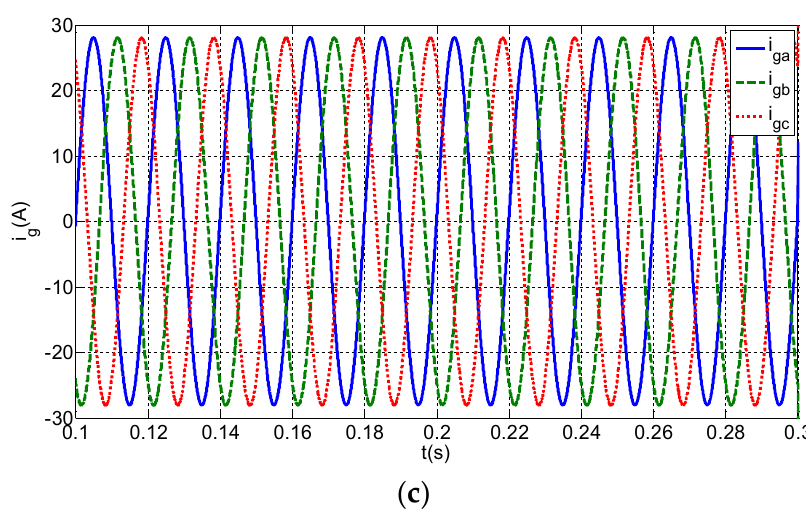
Figure 22. Steady state simulation waveform of unbalanced load compensation: ( a ) Three-phase unbalanced load current; ( b ) The output current of the SPC device; ( c ) Grid current after compensation. A GDS1104B oscilloscope (GWInstek, Ltd., Taiwan, China) is used as the experimental measuring